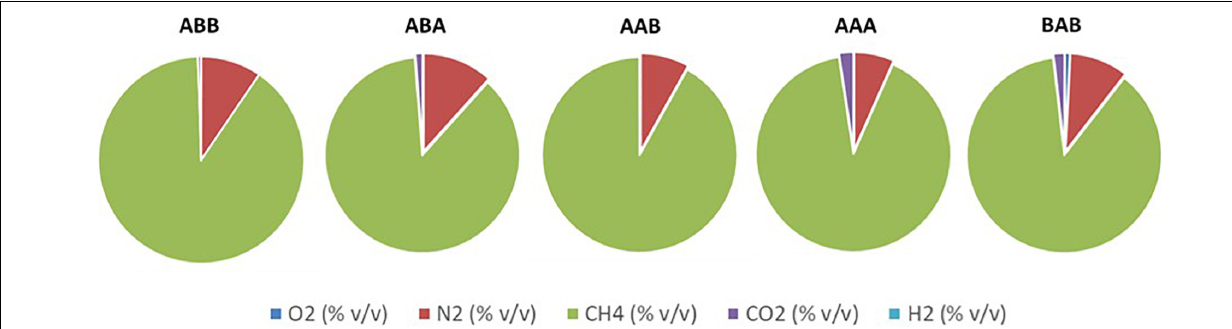
FIGURE 5 | Average biogas composition measured in the tested operation conditions.